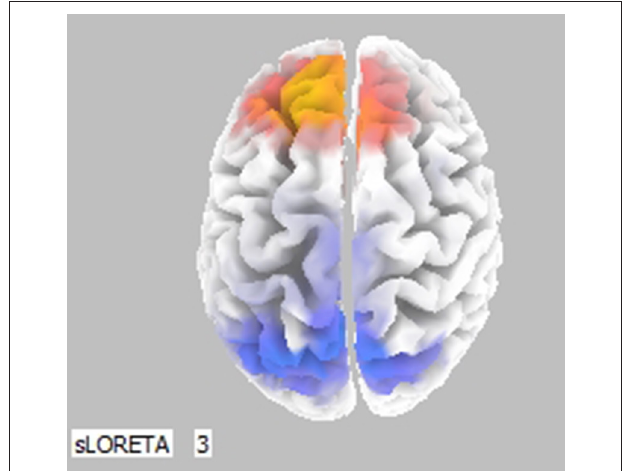
FIGURE 3 | Statistically significant cerebral activity was estimated by LORETA software in the Lower Alpha Band comparing two pieces of information presented in scenario (0, SN + SP) and scenario (0, SP + SN). Orange areas suggest a significant increase in cortical activity for the first scenario (O,